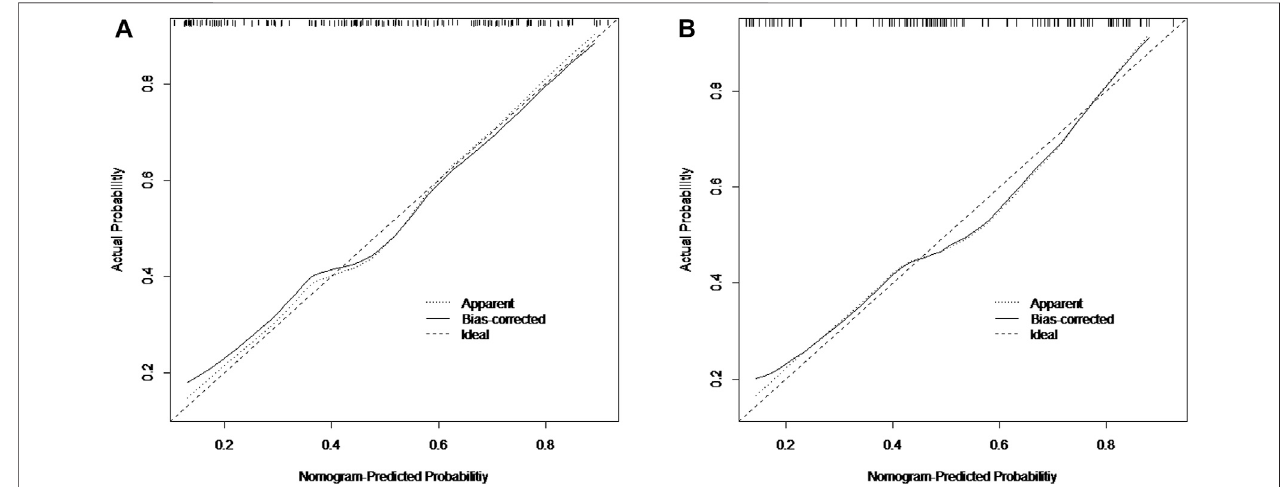
FIGURE 2 | Calibration curves of the nomogram for the training cohort (A) and the validation cohort (B) .